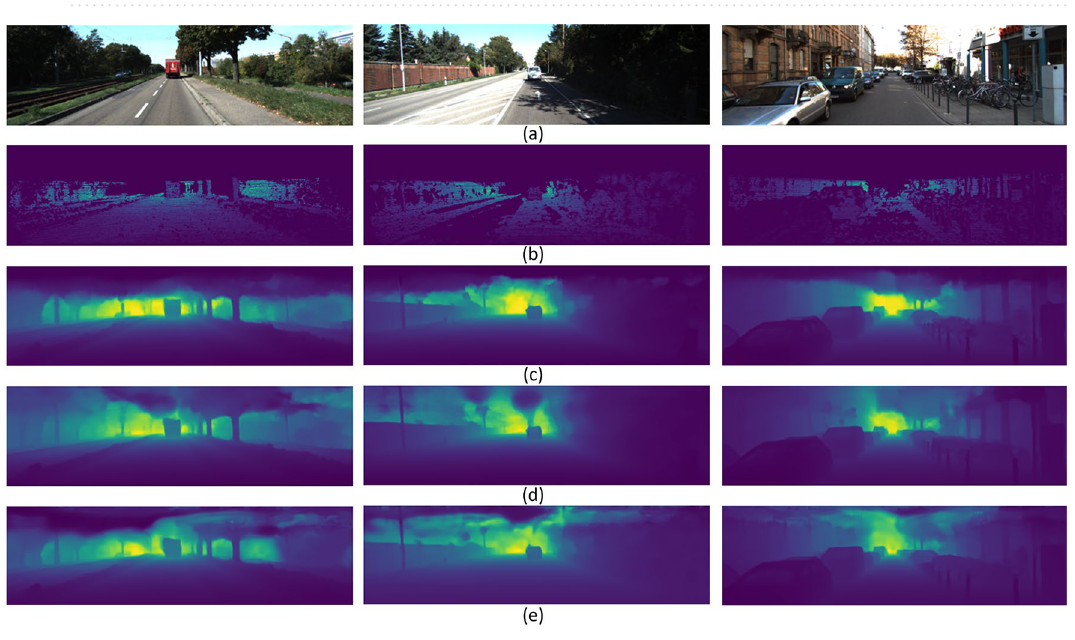
Figure 4. Qualitative evaluation of depth maps on KITTI dataset. ( a ) input RGB images; ( b ) ground-truth depth maps; depth maps predicted by ( c ) Bhat et al. 14 , ( d ) Ranftl et al. 3 , and ( e ) proposed